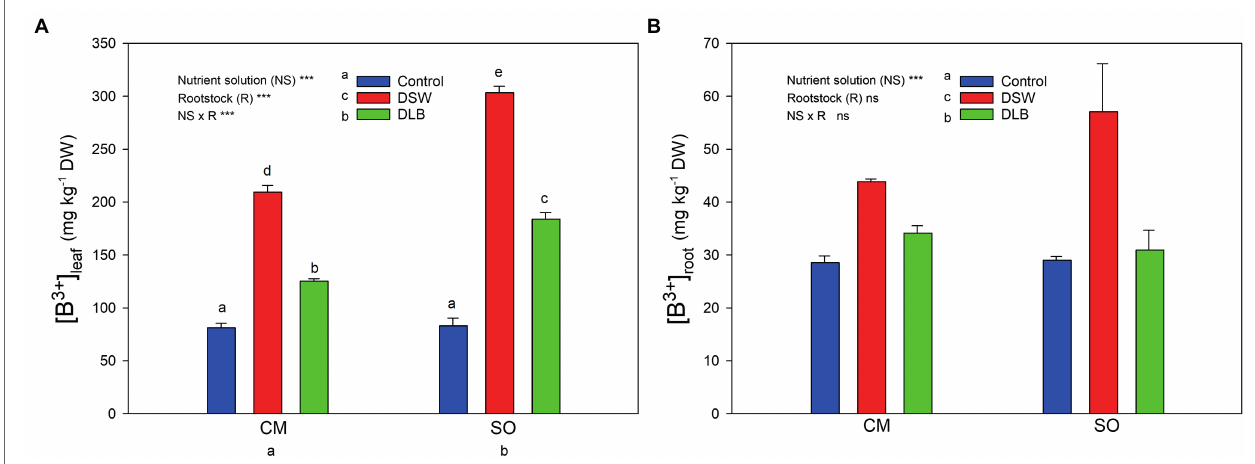
FIGURE 1 | Effects of 7 months of irrigation with nutrient solutions of different characteristics—Control, desalinated seawater (DSW), and DSW with low boron (DLB)—on the B concentration in leaves (A) and roots (B) of ‘Verna’ lemon plants grown on two rootstocks, Citrus macrophylla (CM) and sour orange (SO). Different letters indicate significant differences according to Duncan’s multiple range test at the 95% confidence level.